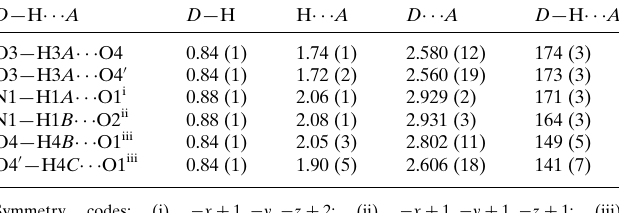
Hydrogen-bond geometry (A˚ , (cid:3) ).